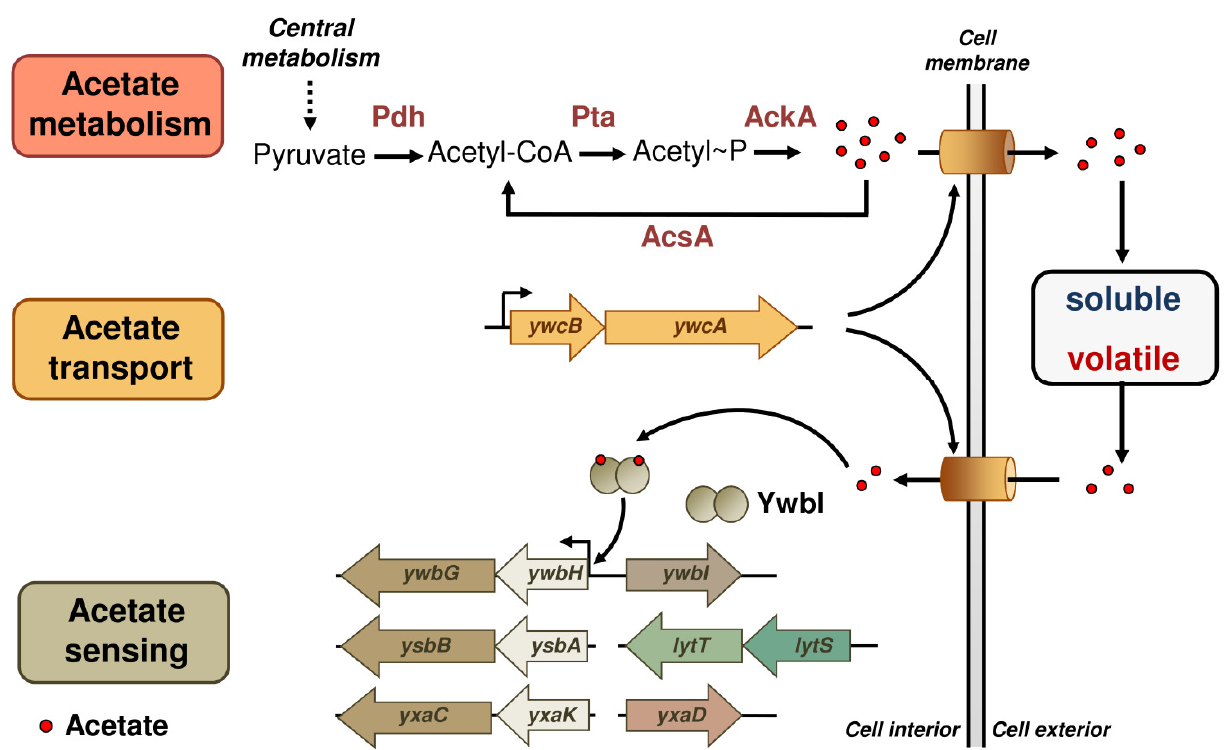
FIGURE 1: A schematic picture of the acetate signaling network in the bacterium Bacillus subtilis . Genes or proteins involved in acetate metabolism (Pdh, Pta, AckA, and AcsA), transport ( ywcB-ywcA ), and sensing ( ywbGHI , ysbBA-lytTS , and yxaCKD ) are described. Secreted acetate can act as either a volatile signal or a canonical quorum-sensing-like signal in